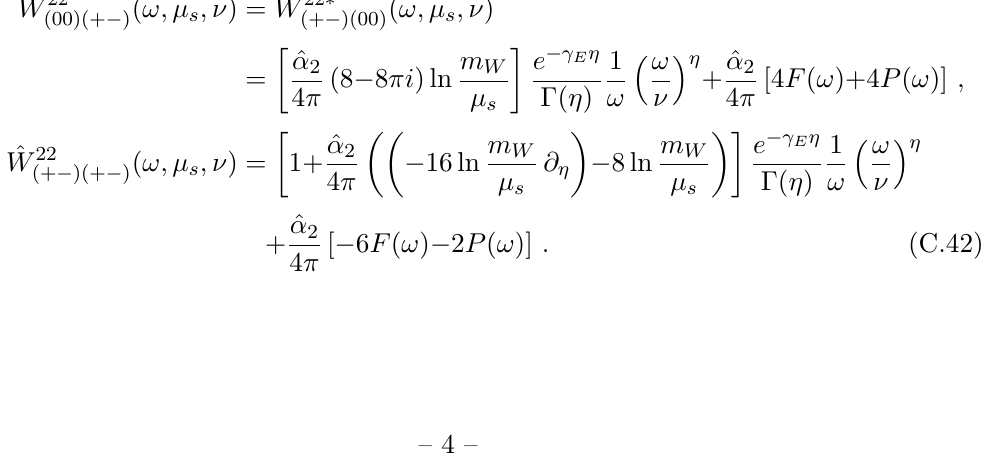
Figure 3 . Integrated photon energy spectrum within E (cid:13) (Sommerfeld only) and LL, NLL, NLL 0 resummed approximation. The energy resolution is set to E (cid:13) = m W . The shaded/hatched bands show the scale variation of the respective approximation res as described in the text. For the NLL 0 result the theoretical uncertainty is given by the thickness of the red